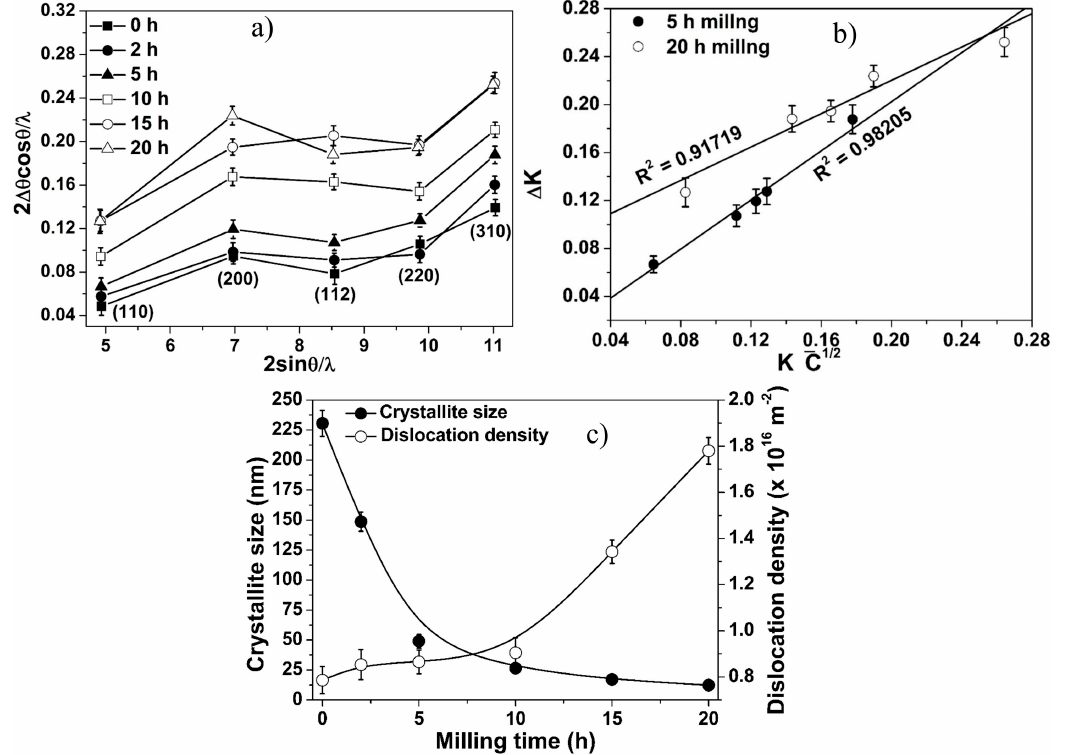
Figure 2. ( a ) Williamson-Hall plots; ( b ) modified Williamson-Hall plots; and ( c ) crystallite size and dislocation density as a function of milling time of Fe–10Cr–3Al alloy powder.